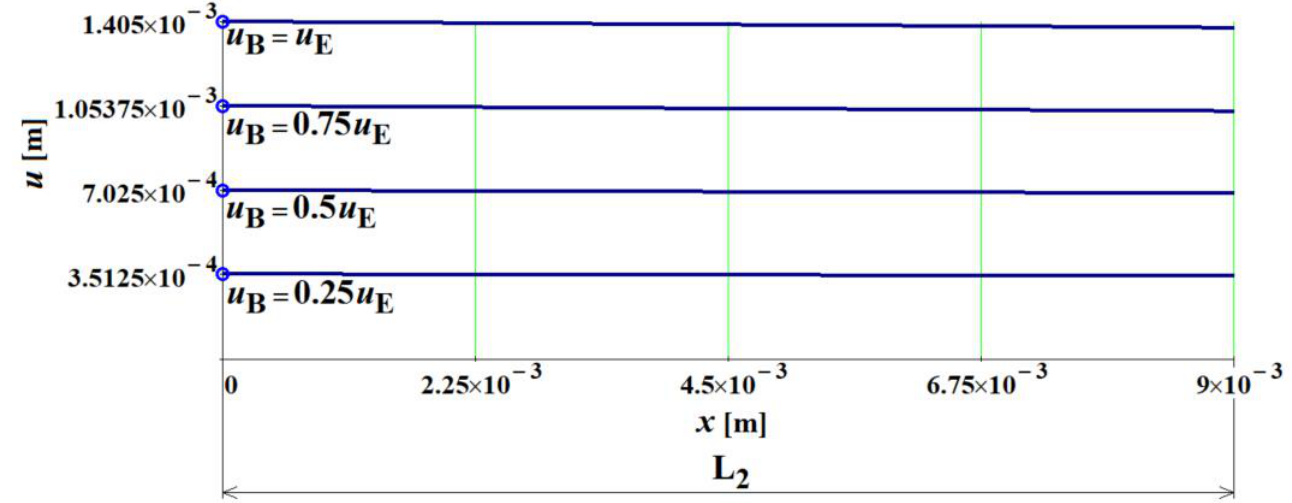
Figure 10. The course of the screw elongation dependence u = f ( u B , x ) for measurement No. 1 (i.e., the solution of Equation